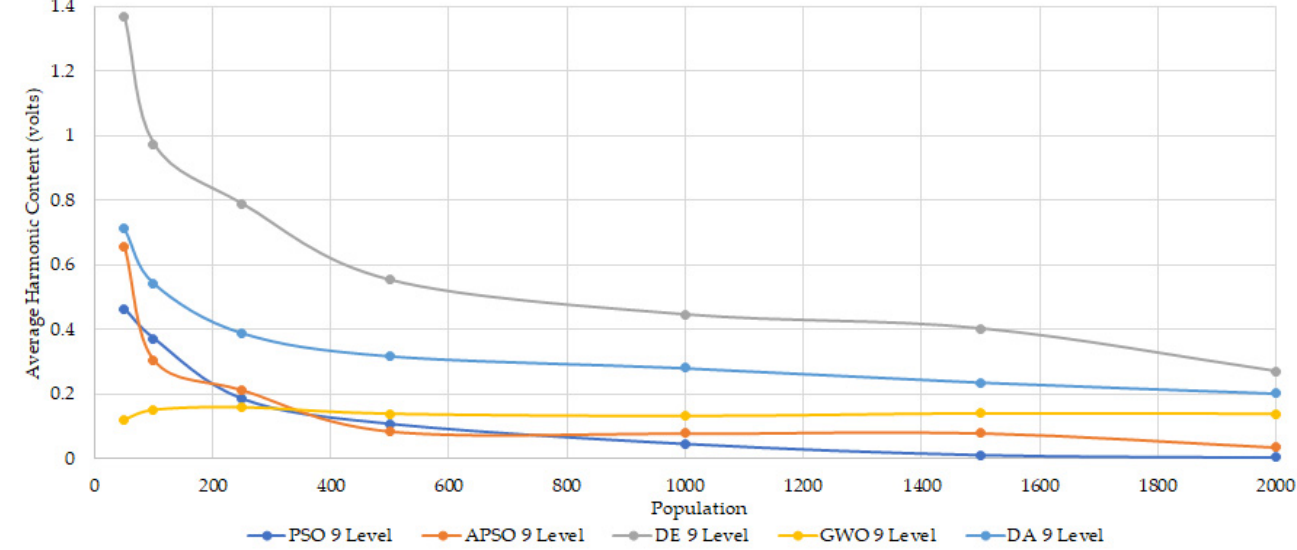
Figure 11. Algorithms’ average performance for a nine-level inverter.